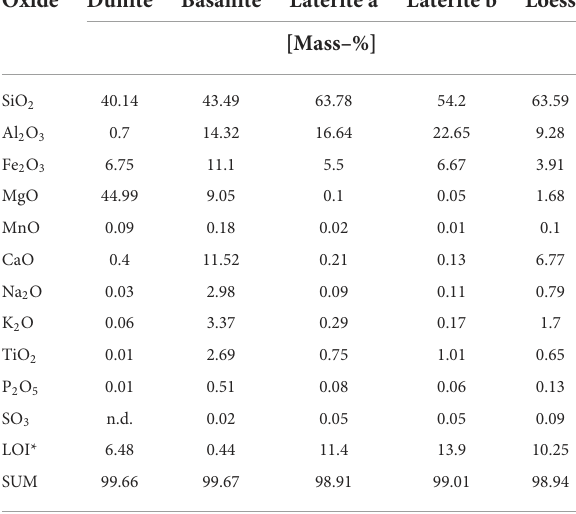
moisture. The average CaCO 3 content is reported as 17–19%,